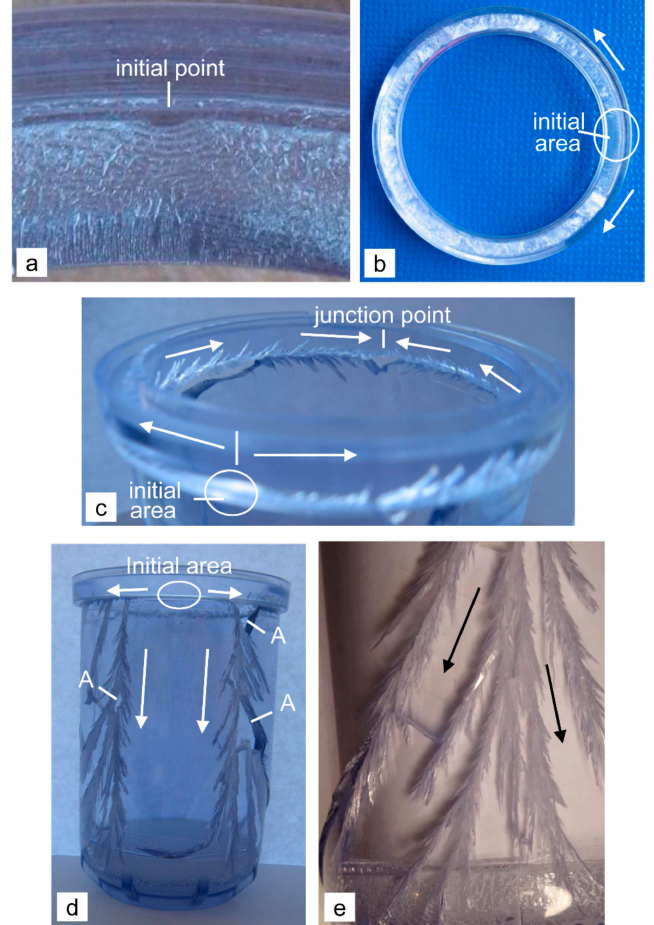
Figure 5. Specific characteristics of the initiation and propagation of the cracks in the sample of series D ( a ) an initiation point ( b ) a detached clamping ring ( c ) junction of the oppositely growing horizontal cracks with a small detached triangular fragment ( d ) strong splitting of vertically downwards-growing cracks ( e ) very densely arranged short secondary cracks along the main cracks; the arrows indicate the direction of the crack